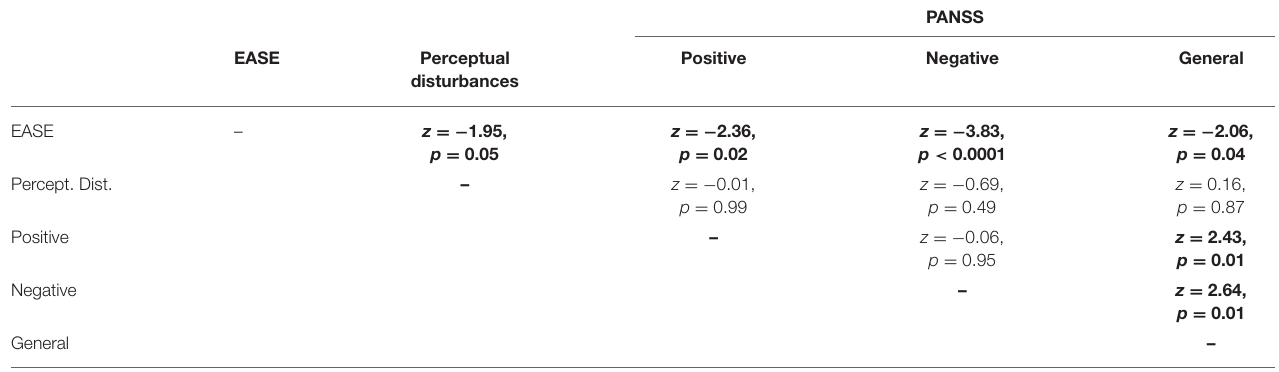
TABLE 3 | Comparison of